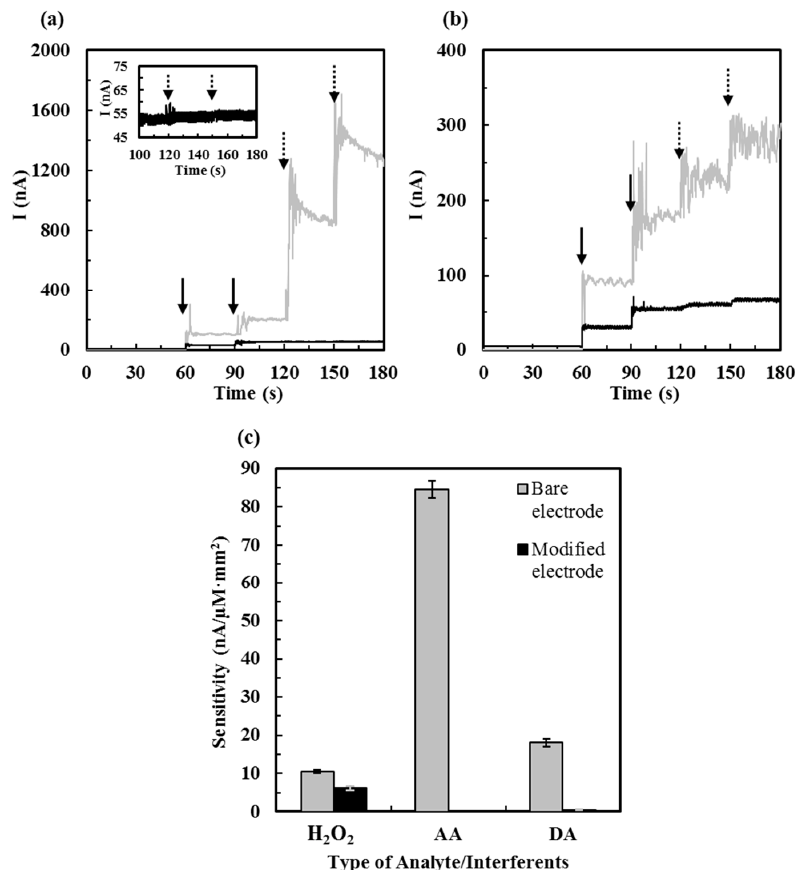
Figure 7. The effect of interference tested on bare Pt electrodes and ALT biosensors. ( a ) Current responses upon sequential additions of 20 µM and 40 µM H 2 O 2 (the injection of H 2 O 2 is indicated by the solid black arrow ) and 250 µM and 500 µM AA (the injection of AA is indicated by the dashed black arrow ) tested on bare Pt electrodes ( ━ gray line ) and ALT biosensors ( ━ black line ). The inset plot shows lower current range; ( b ) Current responses upon sequential additions of 20 µM and 40 µM H 2 O 2 (the injection of H 2 O 2 is indicated by the solid black arrow ) and 5 µM and 10 µM DA (the injection of DA is indicated by the dashed black arrow ) tested on bare Pt electrodes ( ━ gray line ) and ALT biosensors ( ━ black line ); ( c ) Comparison of interferent current responses tested on bare Pt electrodes and ALT biosensors ( N =